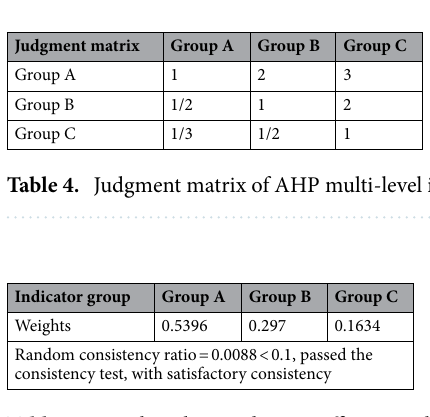
Table 5. Weight values and test coefficients calculated by AHP.